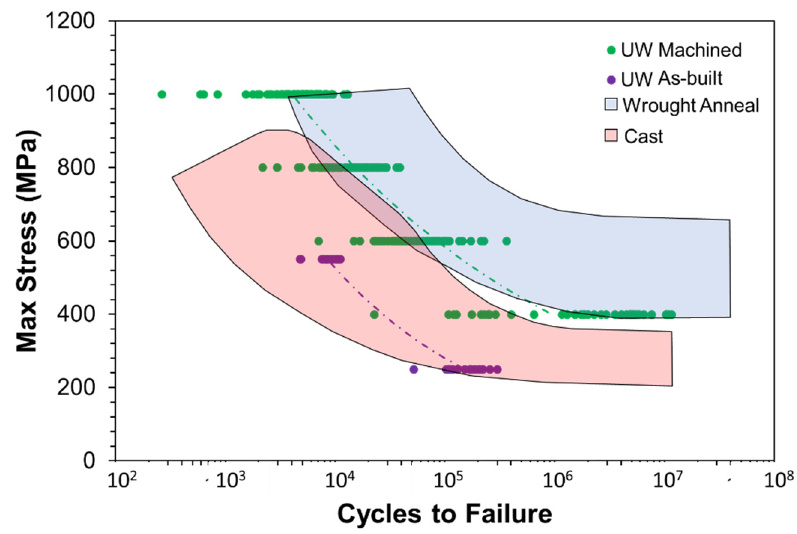
Figure 12. Stress–life diagram comparing the data generated during the fatigue DOE study in both the as ‐ built and machined states against fatigue life range for two traditional Ti6Al4V materials. Fatigue life distributions are extracted from the ASM Handbook